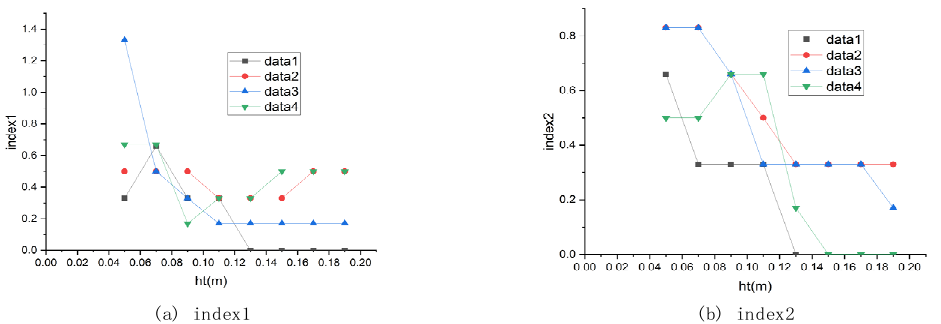
Algorithm 1 will incorrectly classify ground points as non-ground points. After many ex- periments, when the threshold value is around 0.08 m, the classification effect is good. The effect of different height difference threshold on the results is shown in Figure 11.